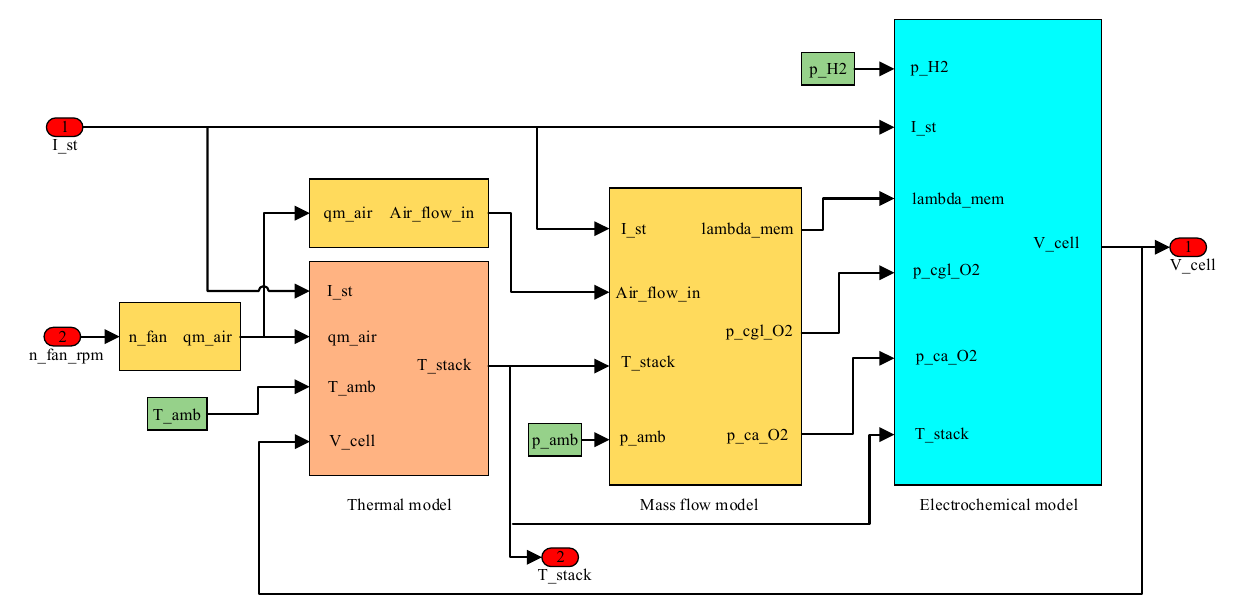
Figure 2. OC-PEMFC Figure 2. OC-PEMFC model.